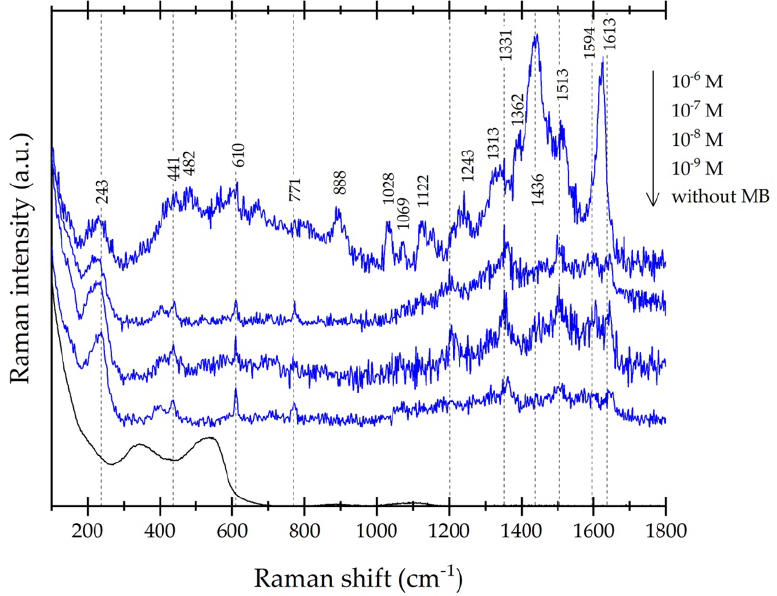
Figure 12. Raman spectra of MB at different concentrations (from 10 − 6 M to 10 − 9 M) measured on Ag/ZnO MSs (9.8 mM of AgNO 3 during 30 min) and Ag/ZnO MSs substrate without MB.